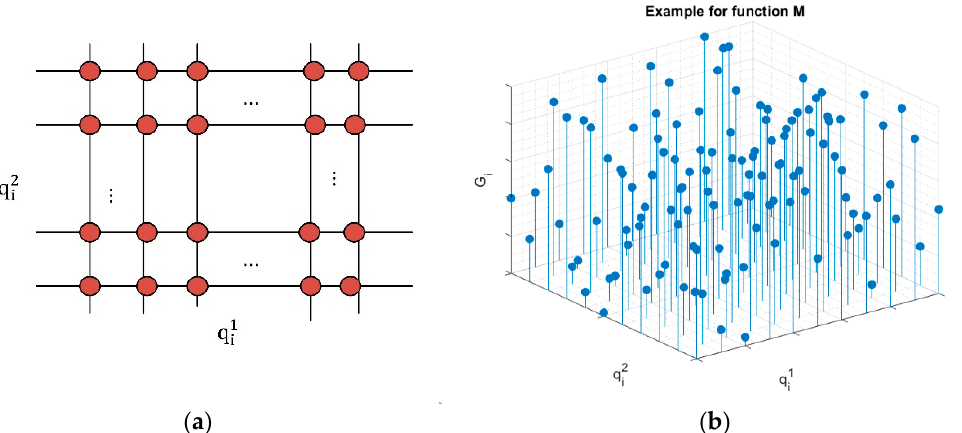
Figure 5. ( a ) Geographical representation of the coverage area for computational purposes. ( b ) Function M (fictional example only for clarification